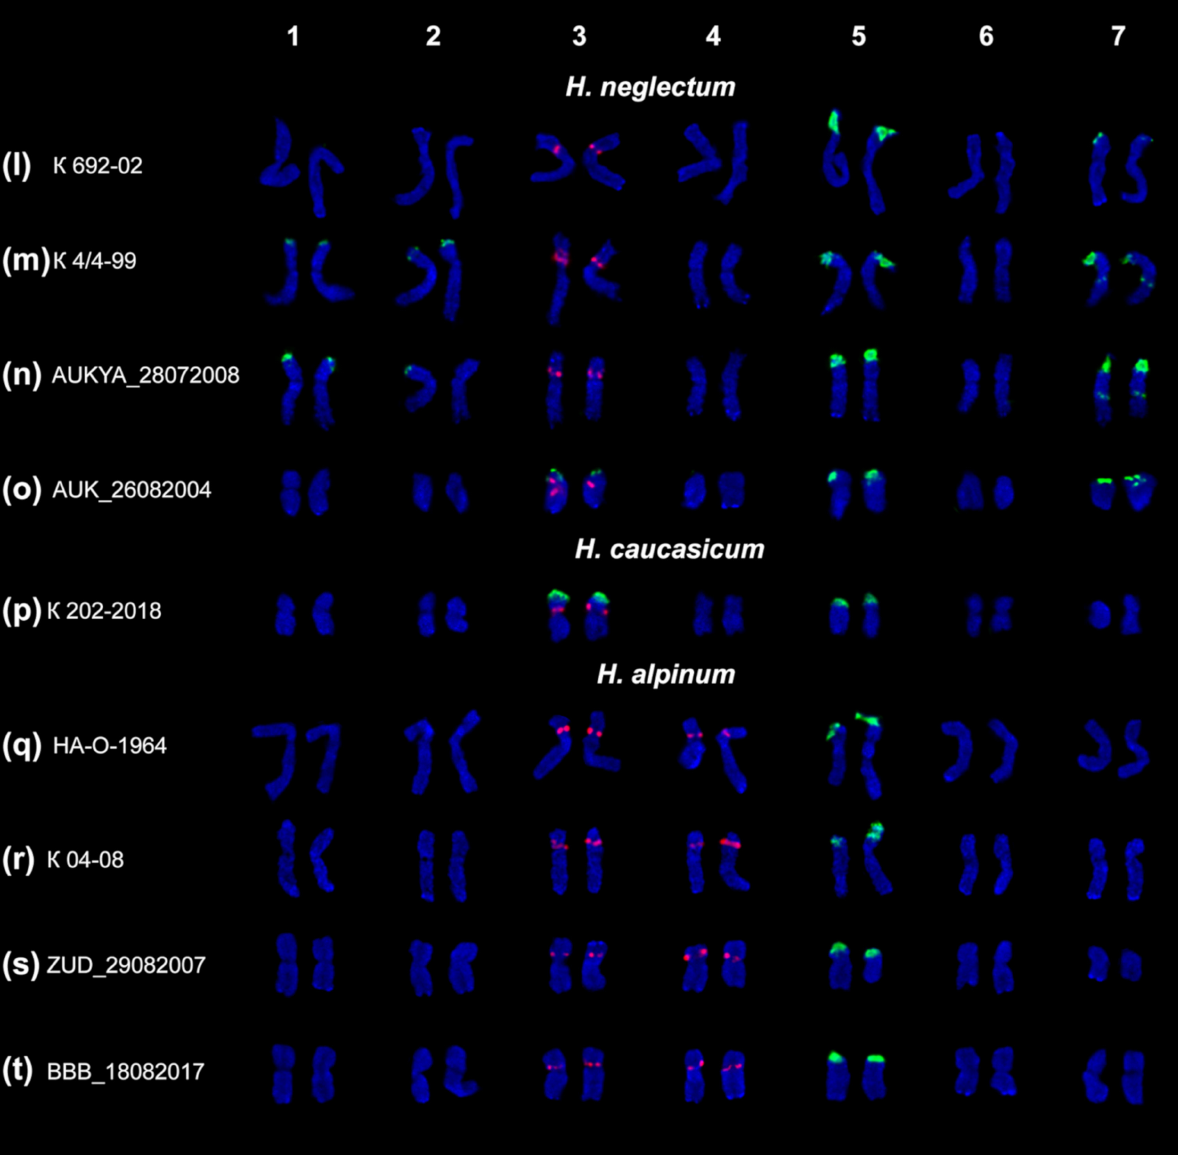
Figure 5. Karyotypes of the studied accessions of H. neglectum ( l – o ) and H. caucasicum ( p ) and H. alpinum ( q – t ). Karyograms of the metaphase plates shown in Figure 3 after FISH with 45S rDNA (green) and 5S rDNA (red). DAPI chromosome